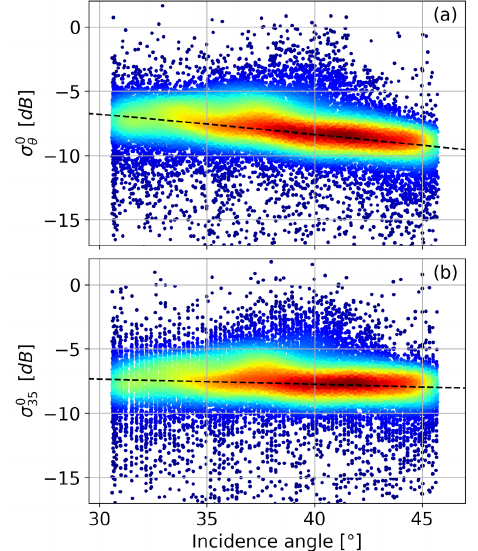
Figure 4. Dependency of backscatter coefficient on incidence angle in three tracks of Sentinel-1 data in ascending passes (shown in Figure 3). (a) σ 0 before normalization and (b) σ 0 after cosine squared normalization to an incidence angle of 35 ◦ . Dashed line represent the line of best fit.